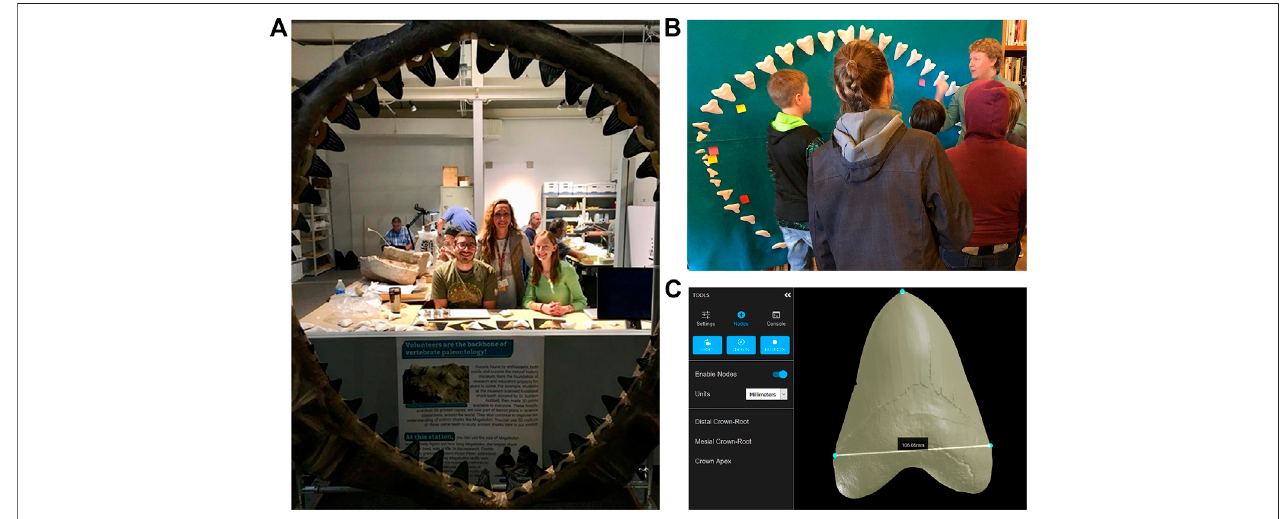
FIGURE 6 | (A) FLMNH vertebrate paleontology public exhibit for the museum ’ s 100-years anniversary, showcasing the use of 3D printing in research and education (B) FLMNH graduate student, Sean Moran, leads a lesson on estimating the body size of C. megalodon at the El Rito Library in New Mexico (sourced from original publication; MacFadden, 2019) (C) A digital interface on MorphoSource to place points and record linear measurements.